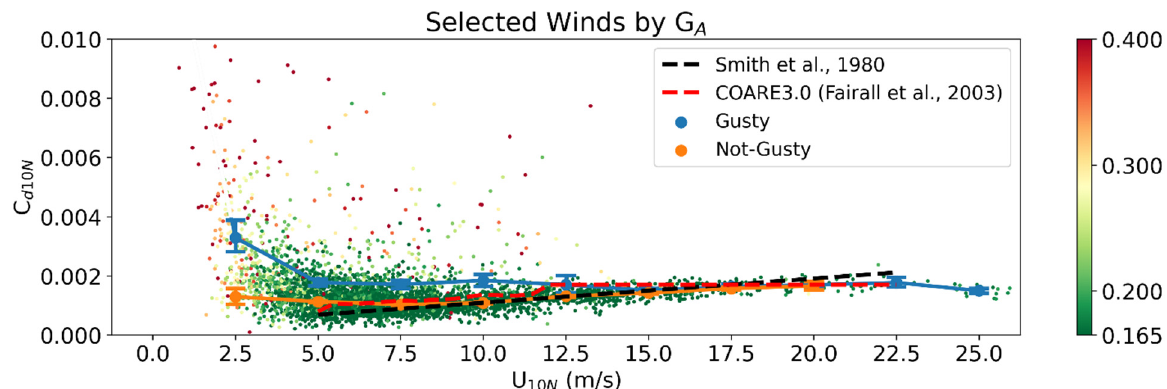
7 of 16 Figure 4. Cumulative probability function of 𝐺 (cid:3002) for entire data set. 𝐺 (cid:3002) (cid:3408) 0.165 means the wind is gusty. Otherwise, the wind is not gusty. The value 0.165 is chosen for best performance. The red line is 𝐺 (cid:3002) = 0.165 . The black dash line is 𝐶𝑃𝐹 = 50% . Based on the formula for 𝐺 (cid:3002) , Figure 5 shows 𝐶 (cid:3031)(cid:2869)(cid:2868)(cid:3015) as a function of 𝑈 (cid:2869)(cid:2868)(cid:3015) . Each data point is color coded by gustiness, with dark green indicating 𝐺 (cid:3002) (cid:3409) 0.165 . When the winds are not gusty, a clear linear relationship between 𝐶 (cid:3031)(cid:2869)(cid:2868)(cid:3015) & 𝑈 (cid:2869)(cid:2868)(cid:3015) emerges. This rela-